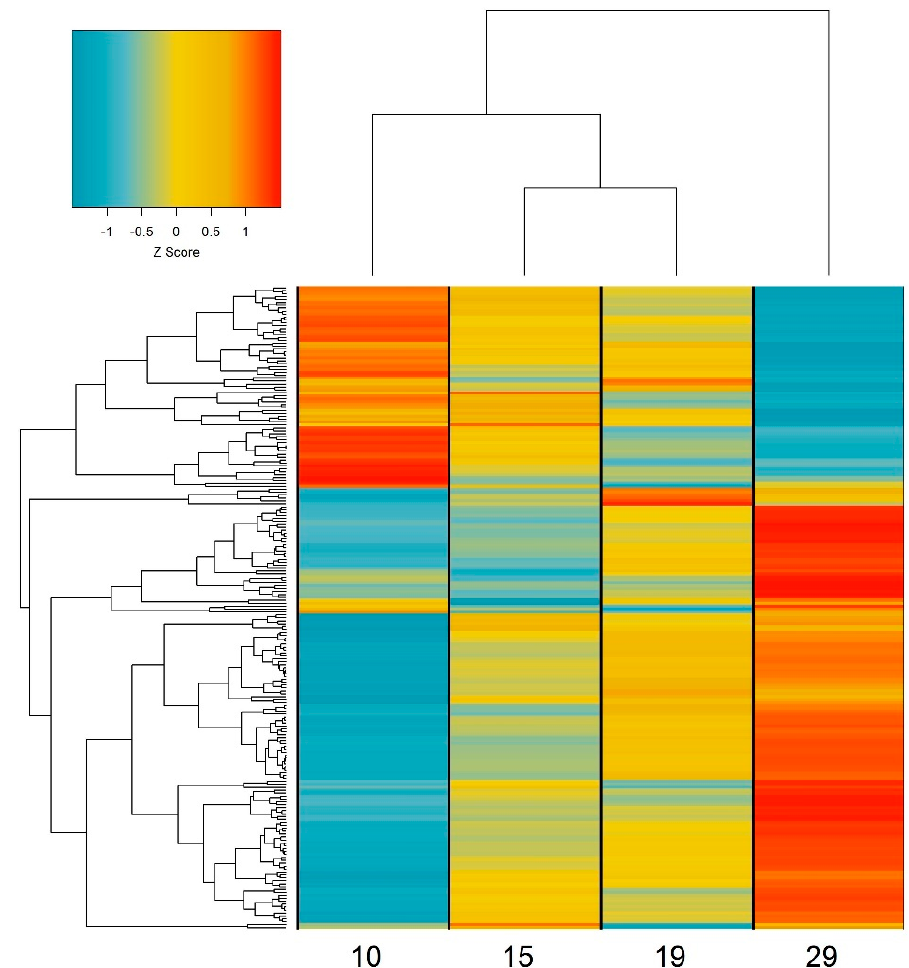
Figure 3. Heatmap and hierarchical clustering of flowering DEGs at 10, 15, 19, and 29 dap. Clustering along the left − hand side indicates relatedness of genes based on their expression pattern, and clustering along the top indicates relatedness of time points. Colour scale is based on Z − scores of TMM − normalized read counts, with blue indicating lower levels of expression and red indicating higher levels of expression.